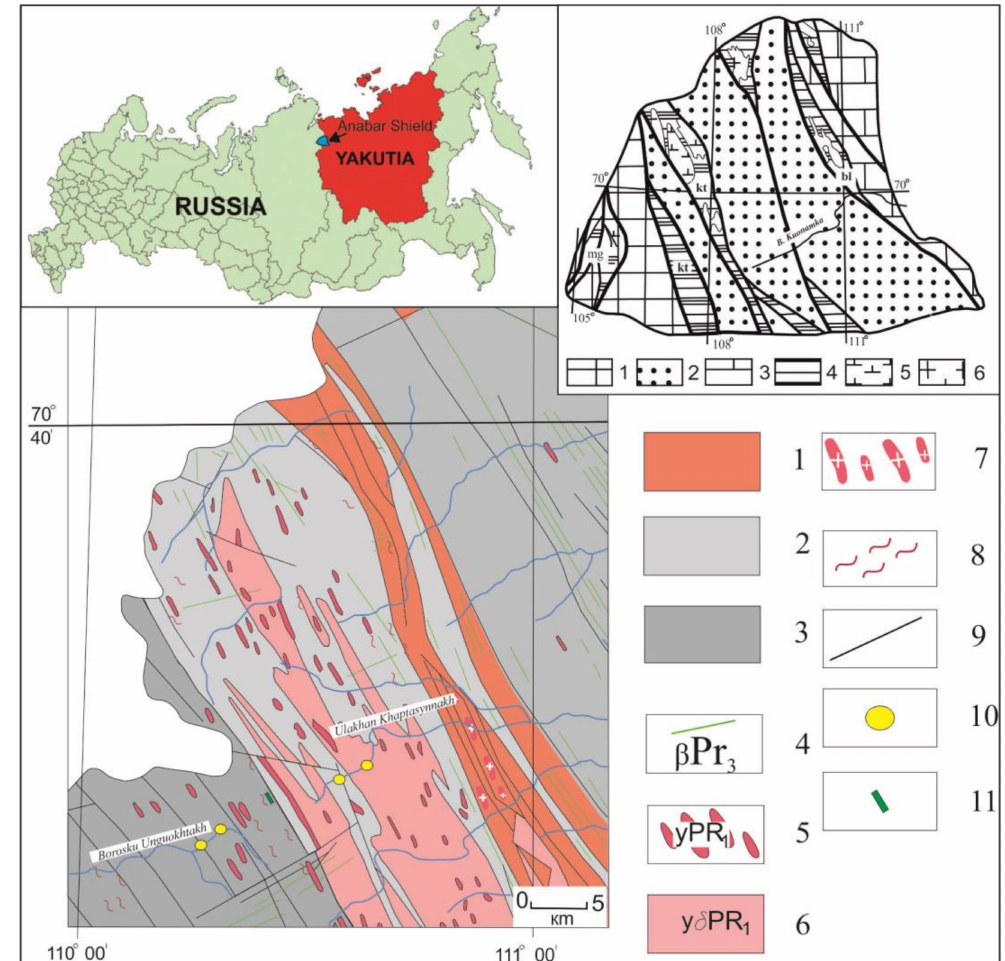
Figure 1. Schematic geological map of the Billyakh zone. 1–3: Precambrian metamorphic complexes (series). 1: Khaptasynnakh (garnet, clinopyroxene, hypersthene–garnet, hypersthene, bipyroxene plagiogneisses, biotite–graphite-bearing varieties of these rocks, calciphyres, marbles, rare beds of sillimanitegneisses, andbasicschists)andBillyakh–Tamakh(garnet, hypersthene–garnetplagiogneisses, and sometimes biotite or graphite-bearing) sequences of the Khapchan series, undi ff erentiated; 2: Upper Anabar series (hypersthene, bipyroxene, and hornblende–bipyroxene plagiogneisses and gneisses; pyroxene–plagioclase and hornblende–pyroxene–plagioclase schists; rare bands of salite and garnet plagiogneisses); 3: Undi ff erentiated metamorphic complexes of the Central Anabar (Daldyn terrane) and East Anabar (Khapchan terrane) geoblocks; 4–7: Intrusive rocks. 4: Meso and Neoproterozoic diabases and gabbro-diabases ( β -PR 3 ); 5: Paleoproterozoic alaskite and leucocratic granites ( γ 1 -PR 1 ); 6: Paleoproterozoic porphyry biotite–hornblende granodiorites, monzonites, granites, and granosyenites ( γ - δ PR 1 ); 7: Paleoproterozoic diorite–syenites, syenites, and granosyenites; 8: Migmatization and granitization zones; 9: Tectonic contacts; 10: Location of small-volume (1 m 3 ) samples; 11: Zone of sulfidized magmatic rocks. The inset map shows the tectonic structure of the Anabar shield: 1–3: Geoblocks; 1: Magan; 2: Daldyn; 3: Khapchan; 4: Tectonic m é lange zones (mg: Magan; kt: Kotuykan; bl: